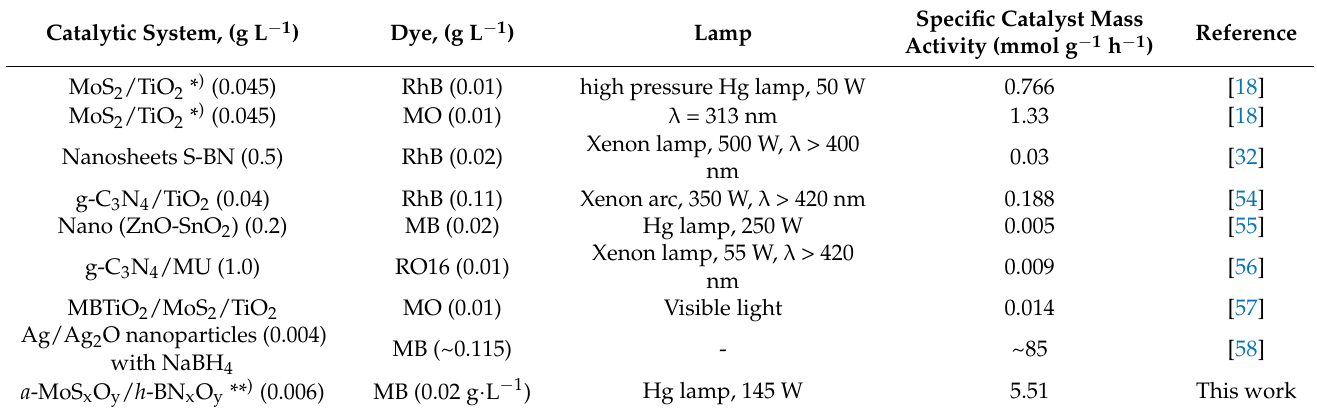
Figure 6. Photocatalytic performance of a -MoS x O y / h -BN x O y catalyst upon decolorization of three concentrations of MB aqueous solutions under UV irradiation ( a ). Reusability of a -MoS x O y / h -BN x O y catalyst during the degradation of a MB aqueous solution under UV irradiation ( b ). Table 4. Photodegradation efficiency of various catalytic